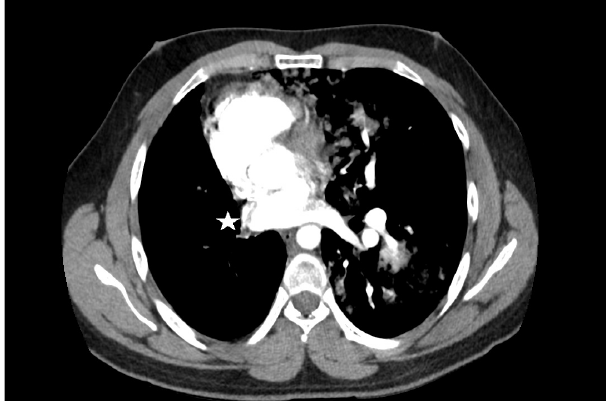
Image 3. An axial view of a contrast-enhanced computed tomography angiography revealing an absent right pulmonary artery